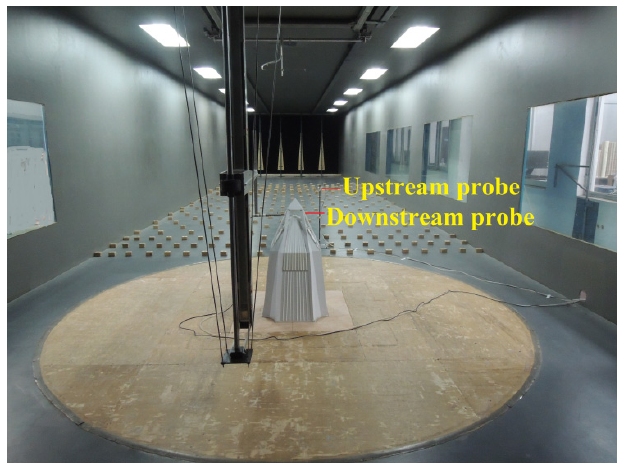
Figure 7 . Overview of WTT. Figure 7. Overview of